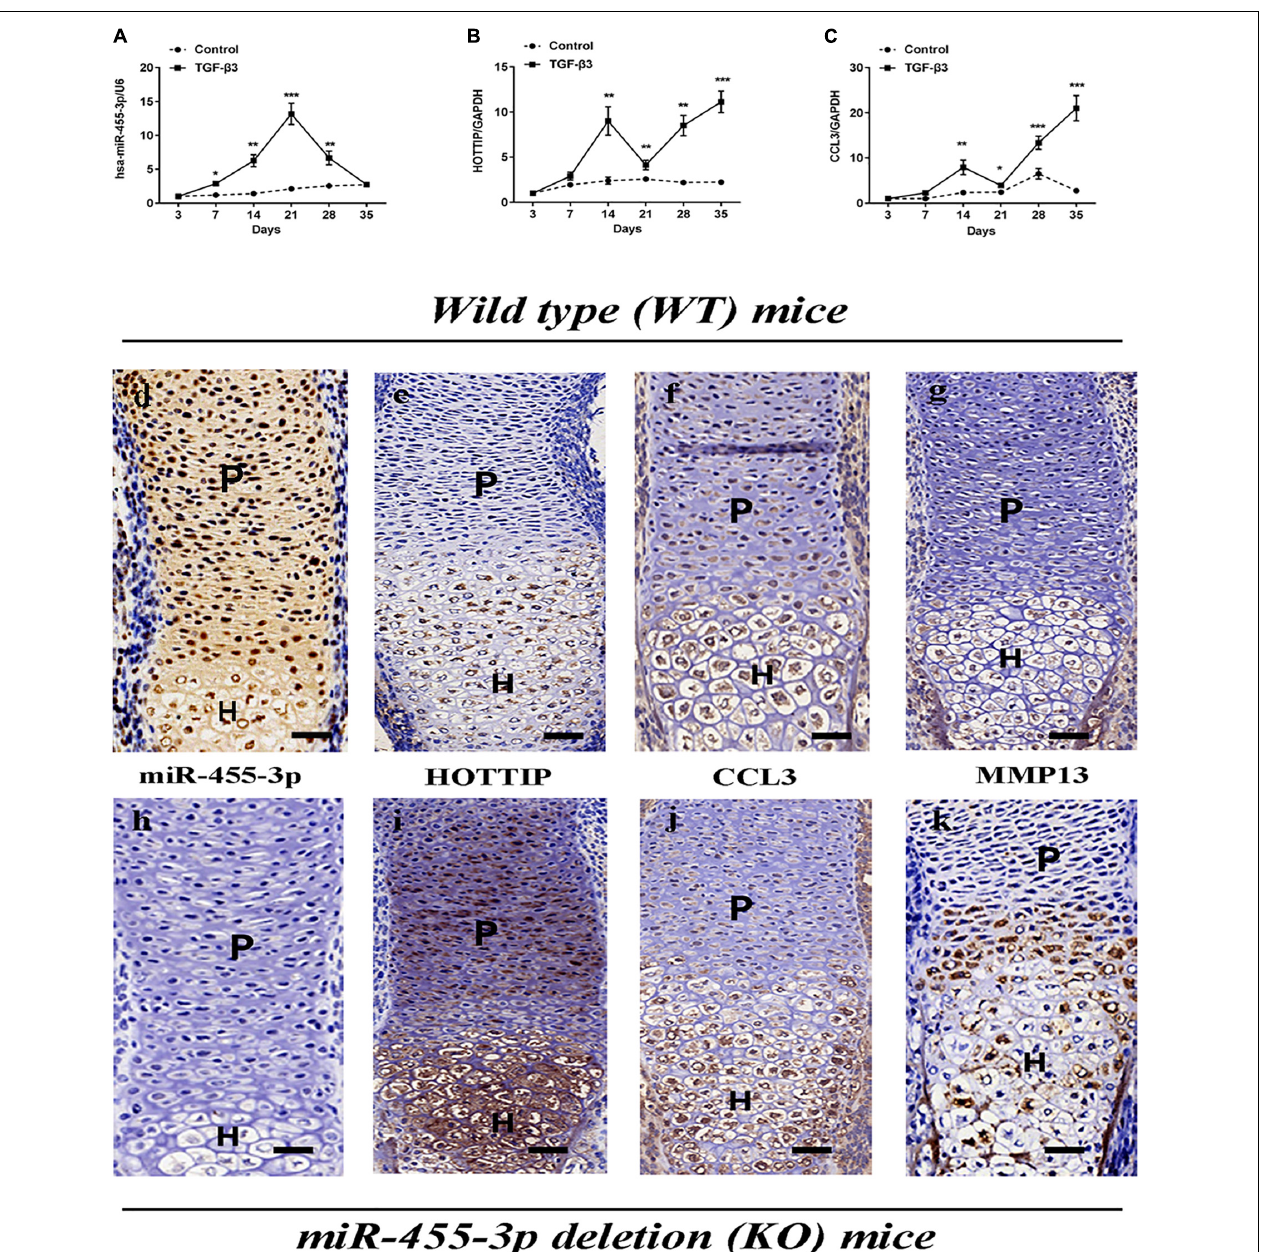
FIGURE 1 | Analysis of the relative expression levels of miR-455-3p, HOTTIP and CCL3 during the chondrogenesis of hMSCs and in forelimbs harvested from WT mice embryos or miR-455-3p-deficient (KO) mice embryos. MSCs were induced to chondrogenesis with TGF- β 3 for 3, 7, 14, 21, 28, and 35 days as indicated (solid lines). Gene expression of miR-455-3p (A) , HOTTIP (B) and CCL3 (C) were determined by RT-qPCR. MSCs cultured without TGF- β 3 at corresponding time points served as negative controls (dashed lines). U6 and GAPDH expression levels were measured and used as internal controls for microRNA and mRNA expression, respectively. The data shown represent the mean ± SD of three independent experiments in samples from three different donors. ∗ P < 0.05. In situ hybridization analysis of miR-455-3p (D,H) and HOTTIP (E,I) expression in tissue sections from the radius of mouse embryos were harvested at 16.5 days post-coitum. Sections were immunostained (brown) with antibodies specific to CCL3 (F,J) and MMP13 (G,K) , respectively. P, proliferating chondrocytes; H, hypertrophic chondrocytes; scale bar: 50 µ